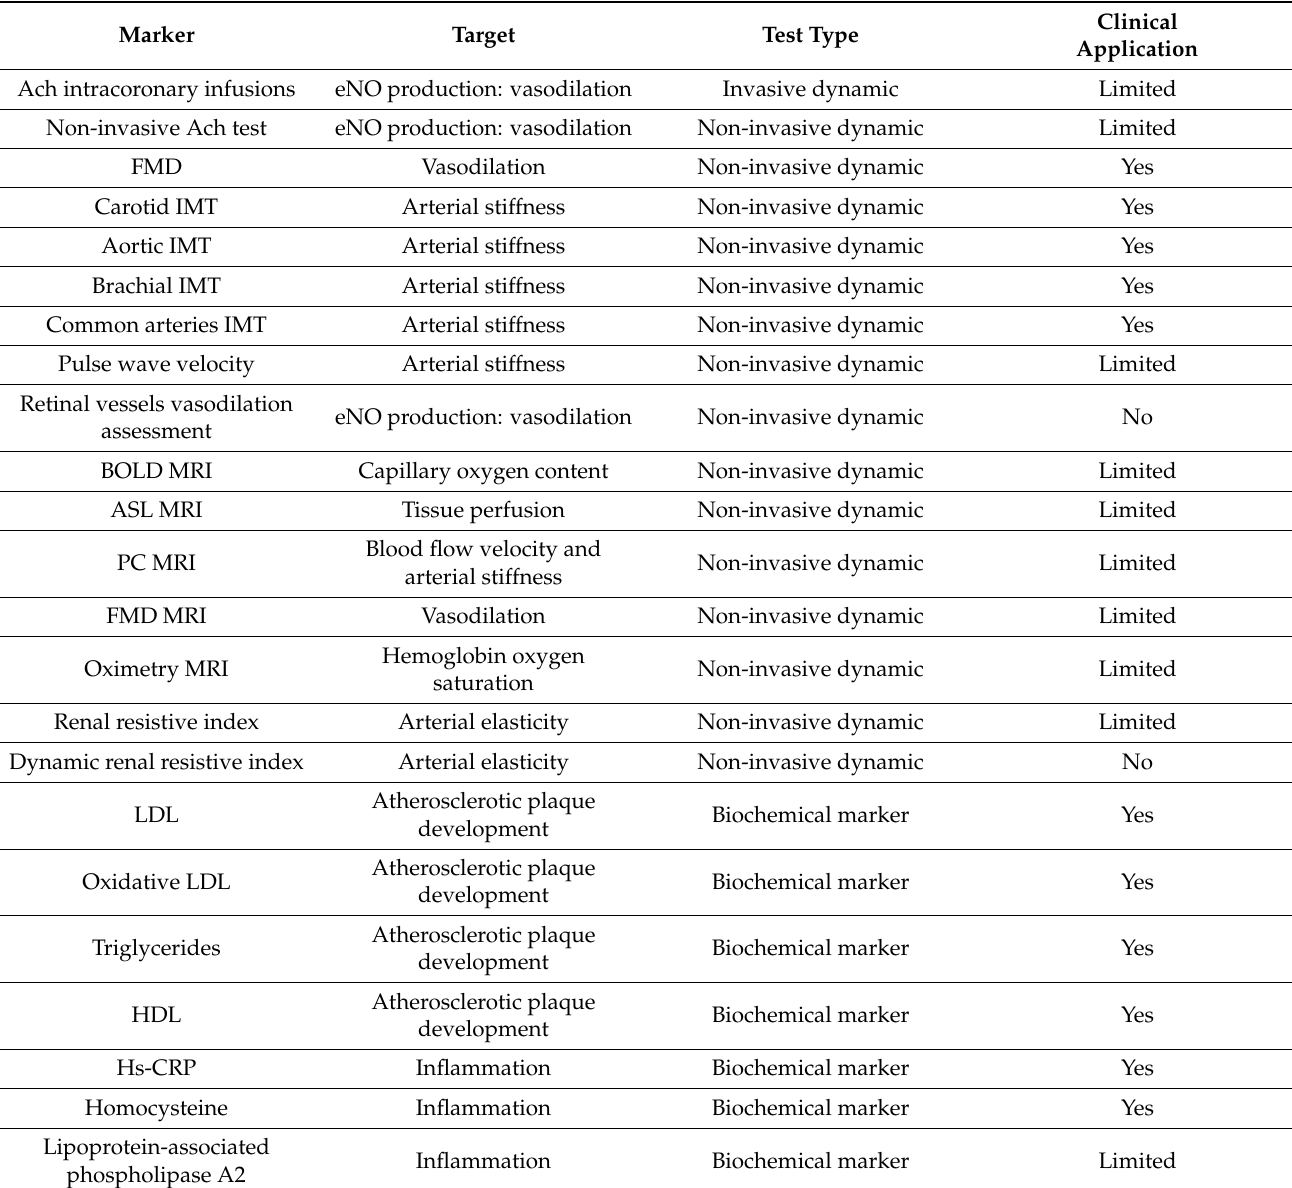
Table 1. Markers of endothelial dysfunction applied to clinical